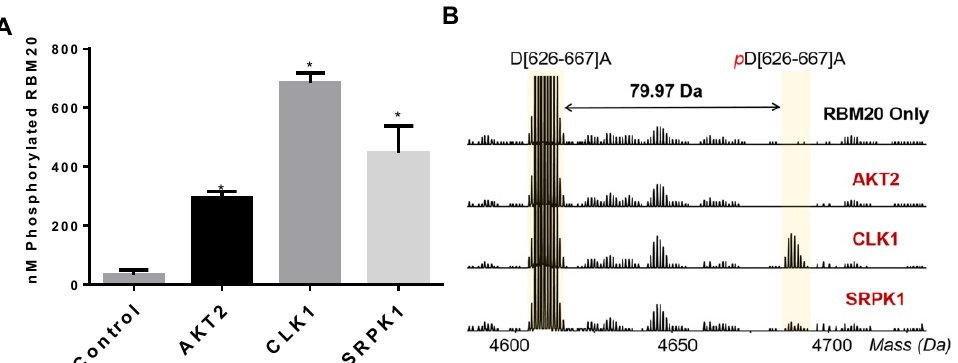
Figure 2. In vitro phosphorylation of RBM20 by AKT2, CLK1, and SRPK1. ( A ) In vitro kinase assay with individual SR protein kinases. Purified RBM20 (5 µ M) was incubated with different kinases in kinase buffer containing 10 µ M 33 P- γ -ATP. The extent of 33 P incorporation upon incubation with each individual kinase was determined in nM. ( B ) Middle-down LC–MS analysis with samples from the in vitro kinase assay. The main peak is 18 × zoomed. Data are presented as mean ± SD ( n = 3); * p < 0.05.